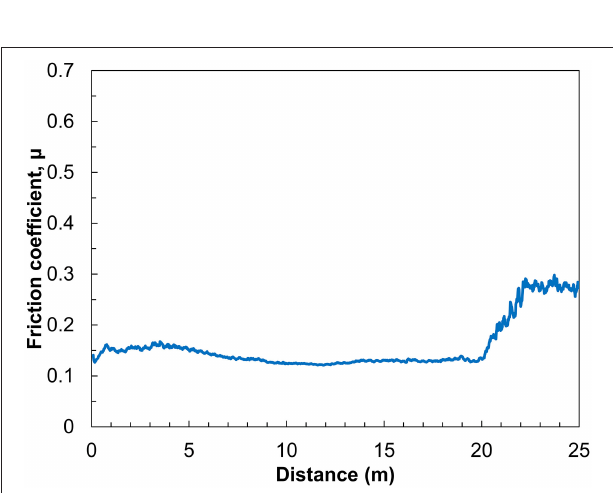
FIGURE 2 | Friction coefficient as a function of sliding distance for three stainless steel balls sliding on a titanium surface in P 6,6,6,14 TFSI. Sliding was carried out under 10N of normal load and a temperature of 60 ◦ C.